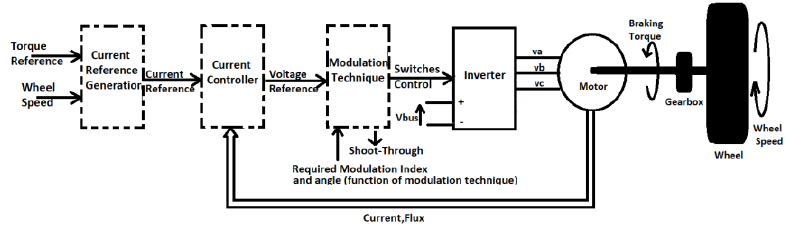
Figure 7. AC control structure.